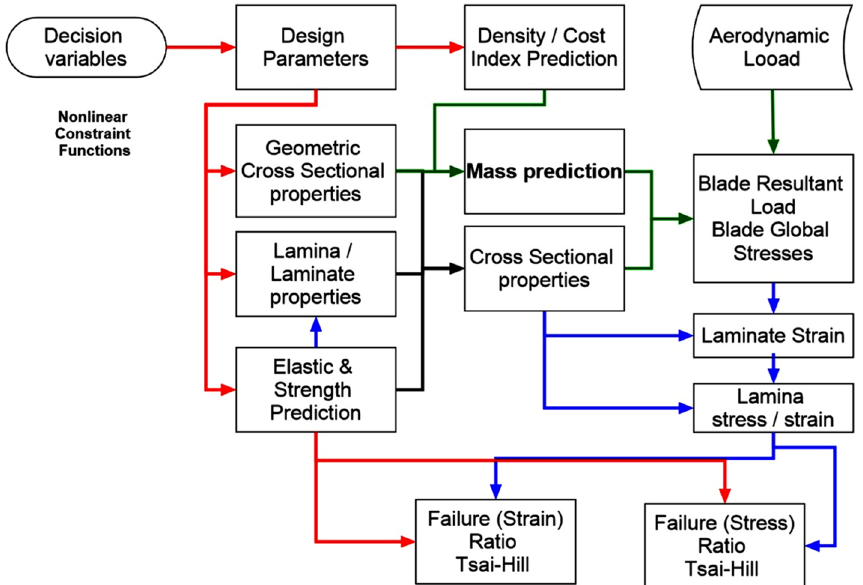
Fig. 6 Evaluation proposed design against failure